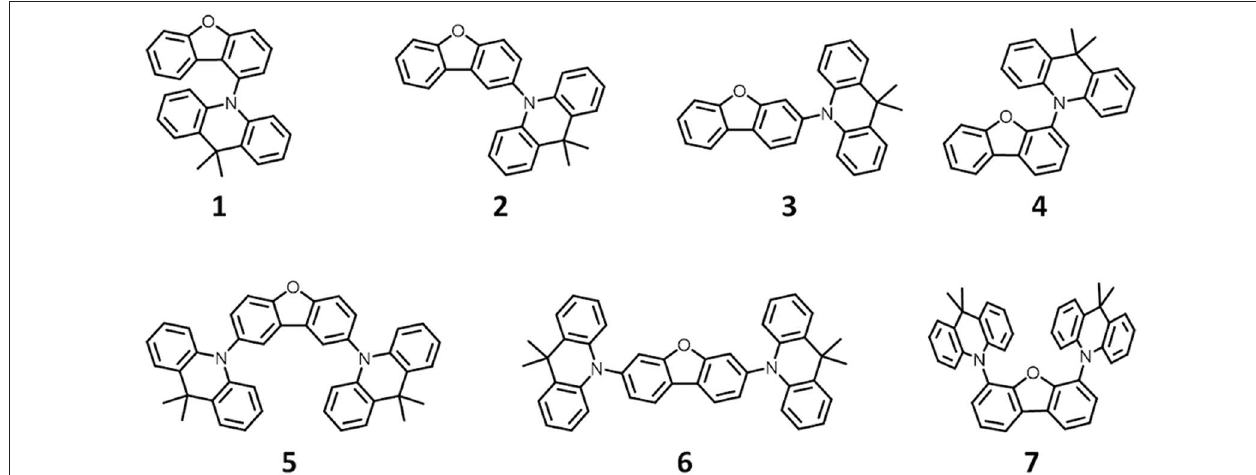
FIGURE 1 | Chemical structures of TADF candidates with homo-junction design.